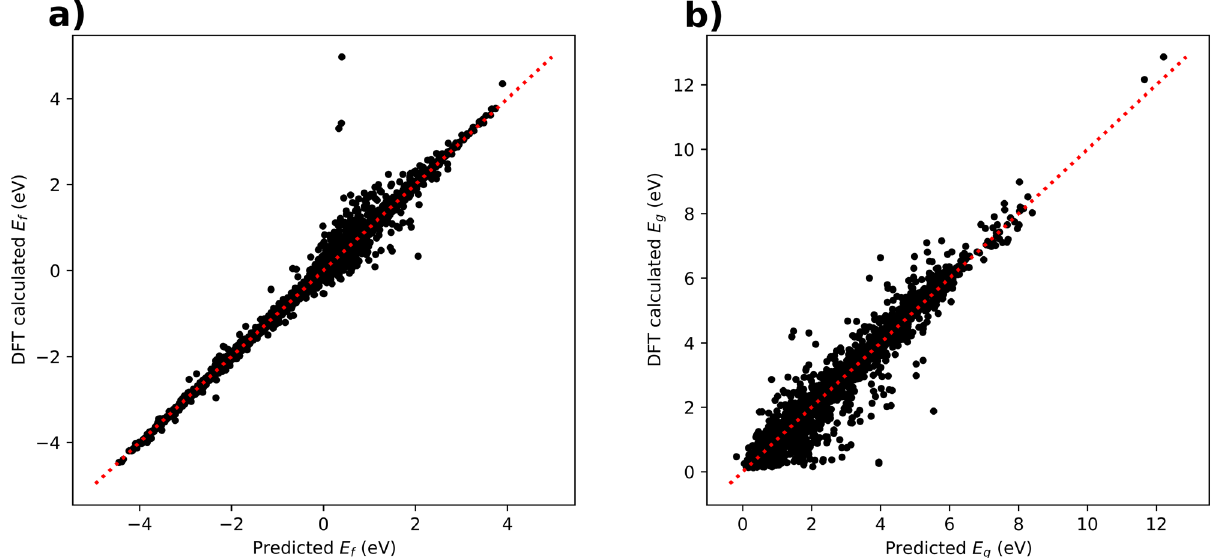
Fig. 4 Comparison between DFT calculations and predictions. a 56K predicted E f versus the corresponding DFT calculated values. The model used is trained by 449K DFT data in the OQMD database. b 3K predicted E g versus the corresponding DFT calculated values. The model used is trained by 24K DFT data in the OQMD